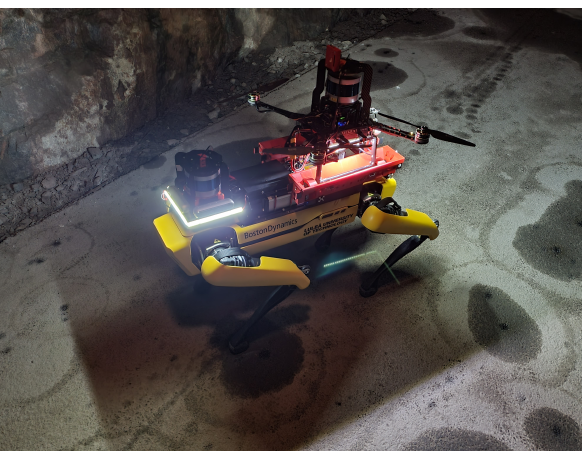
Figure 9. The legged-aerial explorer with its full sensor suite and the drone carrier